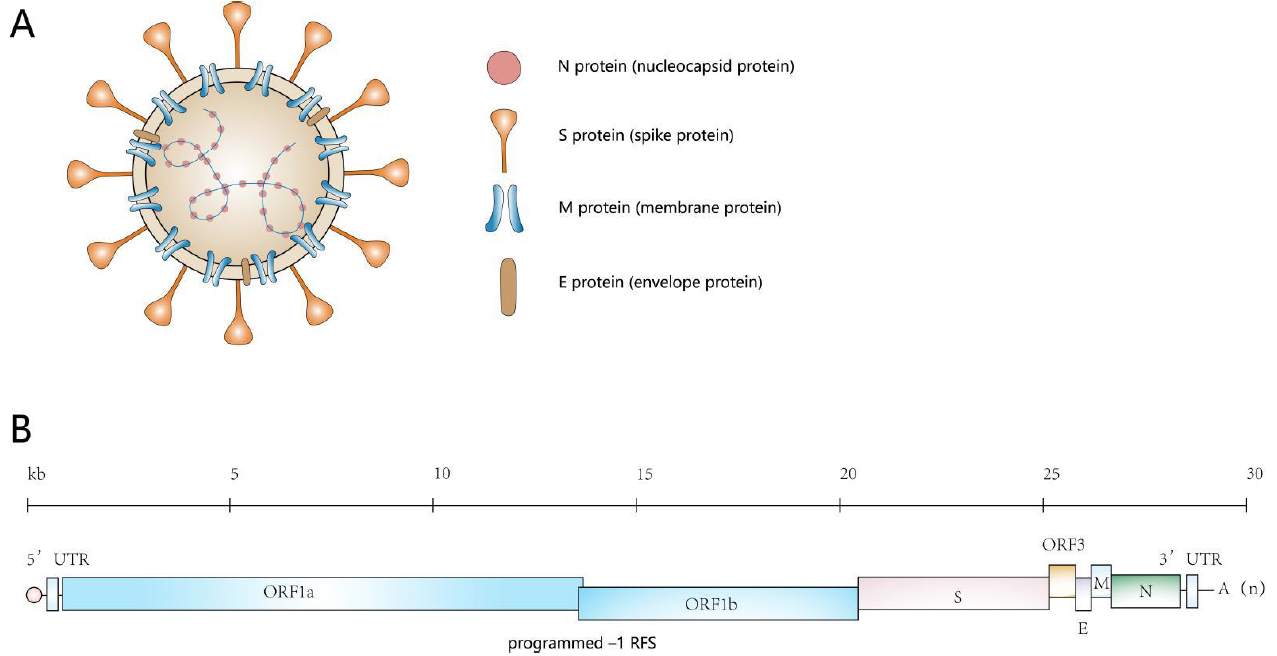
Figure 1. Schematic representation of PEDV genome organization and virion structure. ( A ) Schematic diagram showing the structure of the virus. The lipid bilayer containing the S, M, and E proteins covers the core structure of the viral RNA genome, which is bound to the N protein, forming a long helical ribonucleoprotein (RNP) complex. ( B ) Structure of the RNA genome of PEDV. The RNA genome of PEDV is 28 kb in size and has a 5’ end cap and a 3’ polyadenylated tail. The viral genome is flanked by UTRs and contains seven open reading frames: ORF1a, ORF1b, S, ORF3, E, M, and N; these are indicated by the boxes. (PEDV’s ORF1a and ORF1b have an overlapping region within which the programmed – 1 ribosomal frameshift (RFS) occurs.)